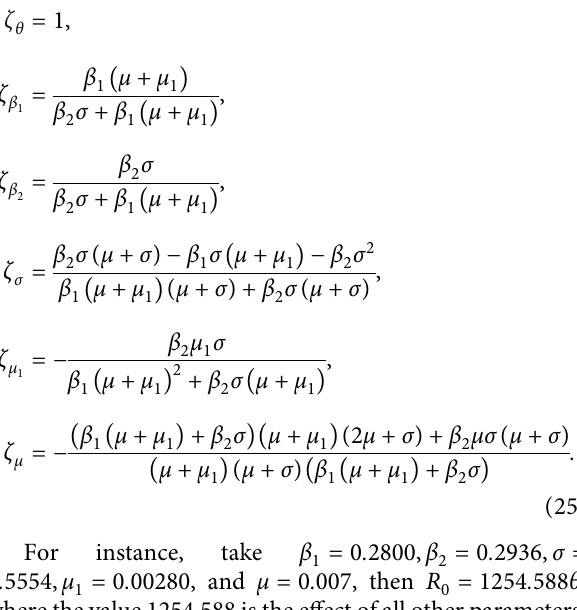
Table 3: Sensitivity indexes of R